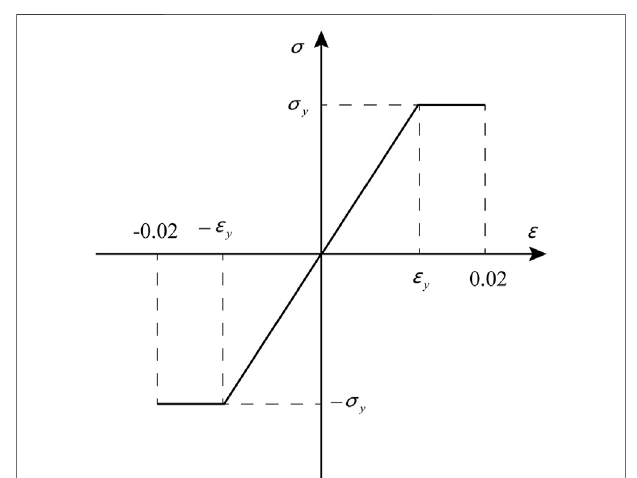
FIGURE 2 | Material model of tower member.